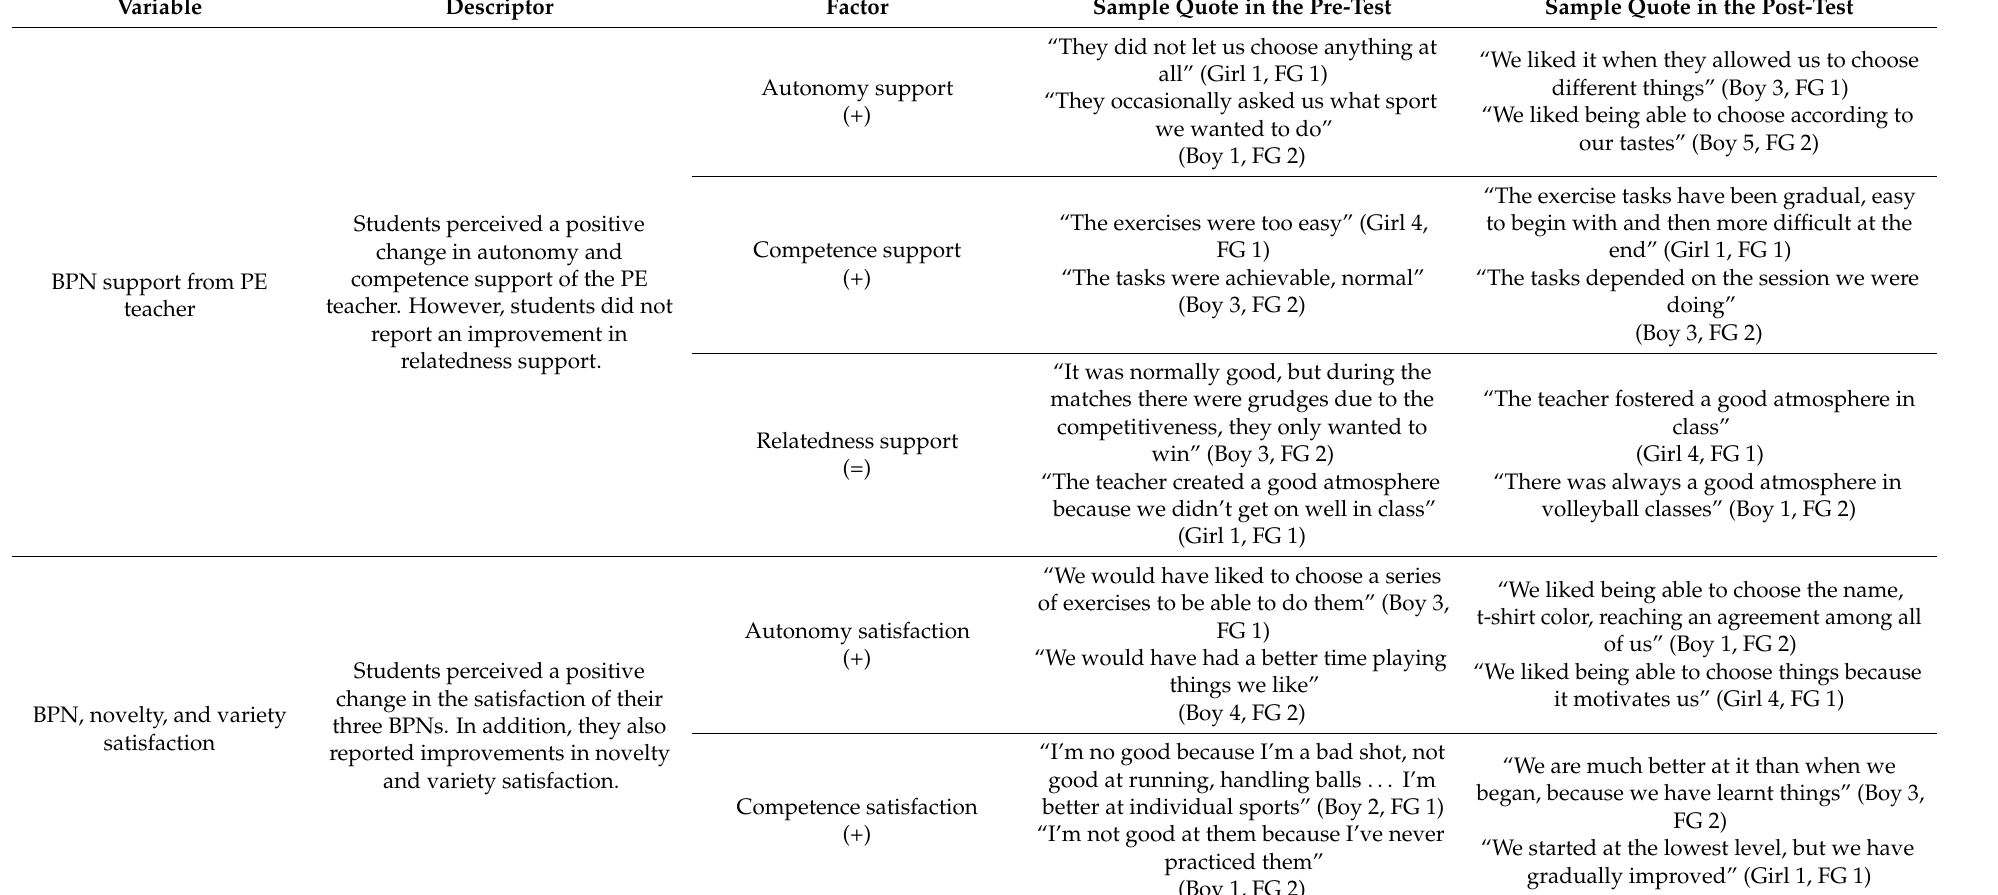
Table 6. Students’ qualitative responses about study variables before and after conducting the TGfU/SE hybrid